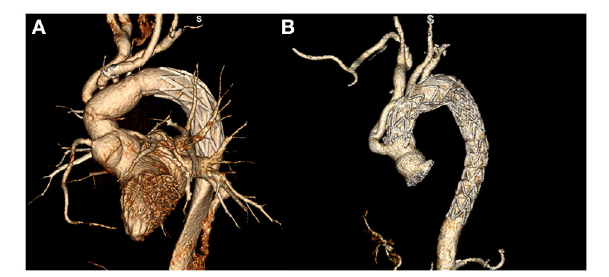
FIGURE 1 | Post-operative aortic CTA reconstruction images of patients with acute aortic syndrome treated with total arch replacement combined with frozen elephant trunk implantation (A) and hybrid debranching surgery (B)